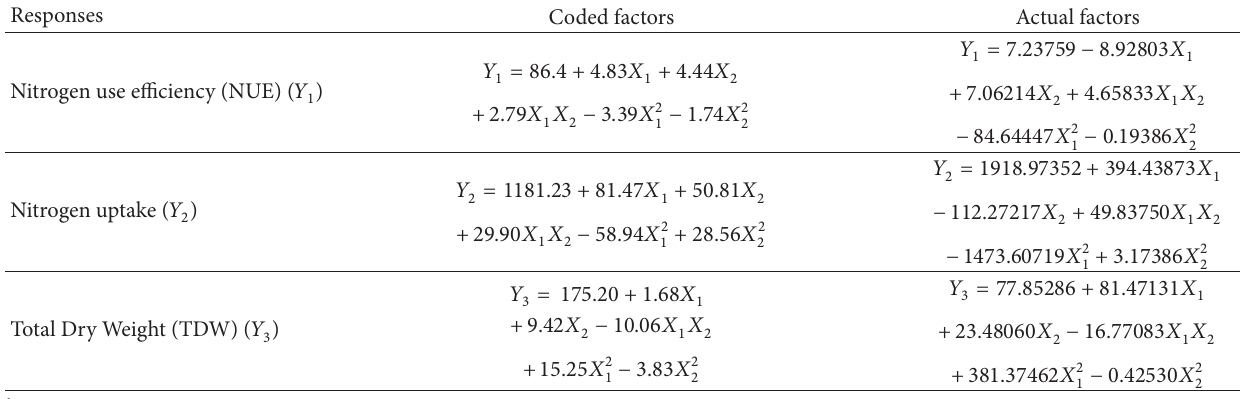
Table 4: Final equations to predict the responses as a function of specified design factors ( a 𝑋 1 and b 𝑋 2 ) in terms of coded and actual factors for parameters.